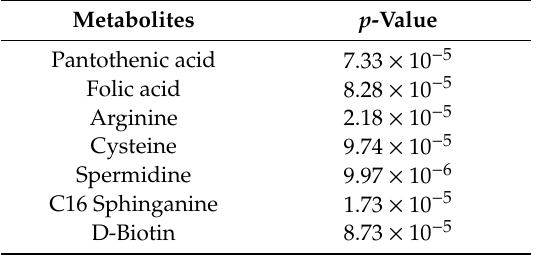
Table 4. List of Most Downregulated Metabolites in HTFs-Treated Group. From the downregulated list, seven metabolites were identified as the most downregulated metabolites in ranibizumab-treated